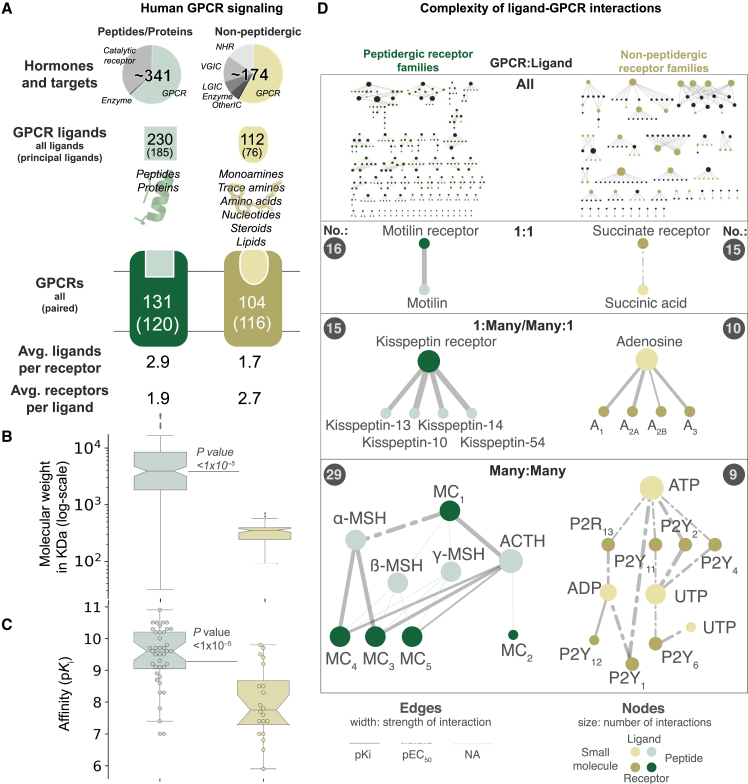
The Human G Protein-Coupled Receptor-Ligand System(A) GPCRs represent the predominant targets for endogenous ligands. Peptides are more numerous, larger and bind with higher affinity than non-peptide ligands. From the top: (1) distinct endogenous ligands by target family; (2) endogenous GPCR ligands, of which “principal” ligands are considered most physiologically relevant; (3) peptide and small-molecule binding receptors, of which “paired” ones have a known principal endogenous ligand; and (4) ligands per receptor and vice versa (averages).(B and C) Ligand molecular weight distribution (B) and cognate receptor affinity (C) (boxplots show a median and interquartile range of 1.5; Wilcoxon rank-sum test, p < 1 × 10−5). Data are from the Guide to Pharmacology database (Harding et al., 2018).(D) GPCR-ligand systems vary in complexity from 1:1 to many:many (gray circles show numbers of each system; data are shown in Table S1).See also Figure S2.